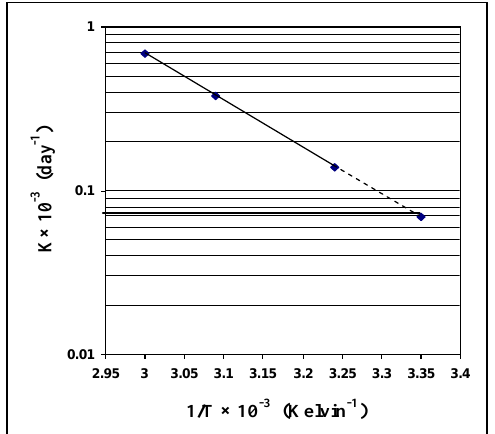
Figure (9): Arrhenius plot for expiration date estimation of naproxen in the selected